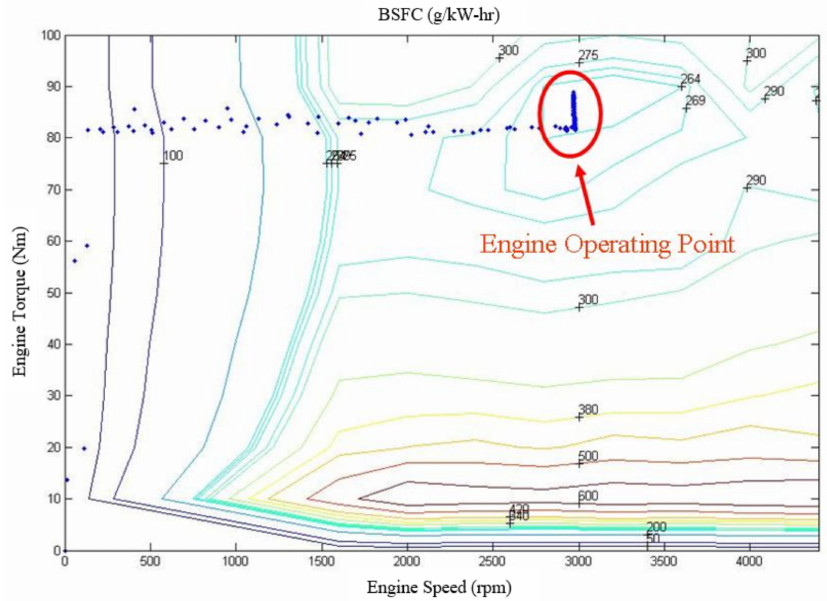
Figure 10. ICE BSFC diagram with the NEDC2000 driving